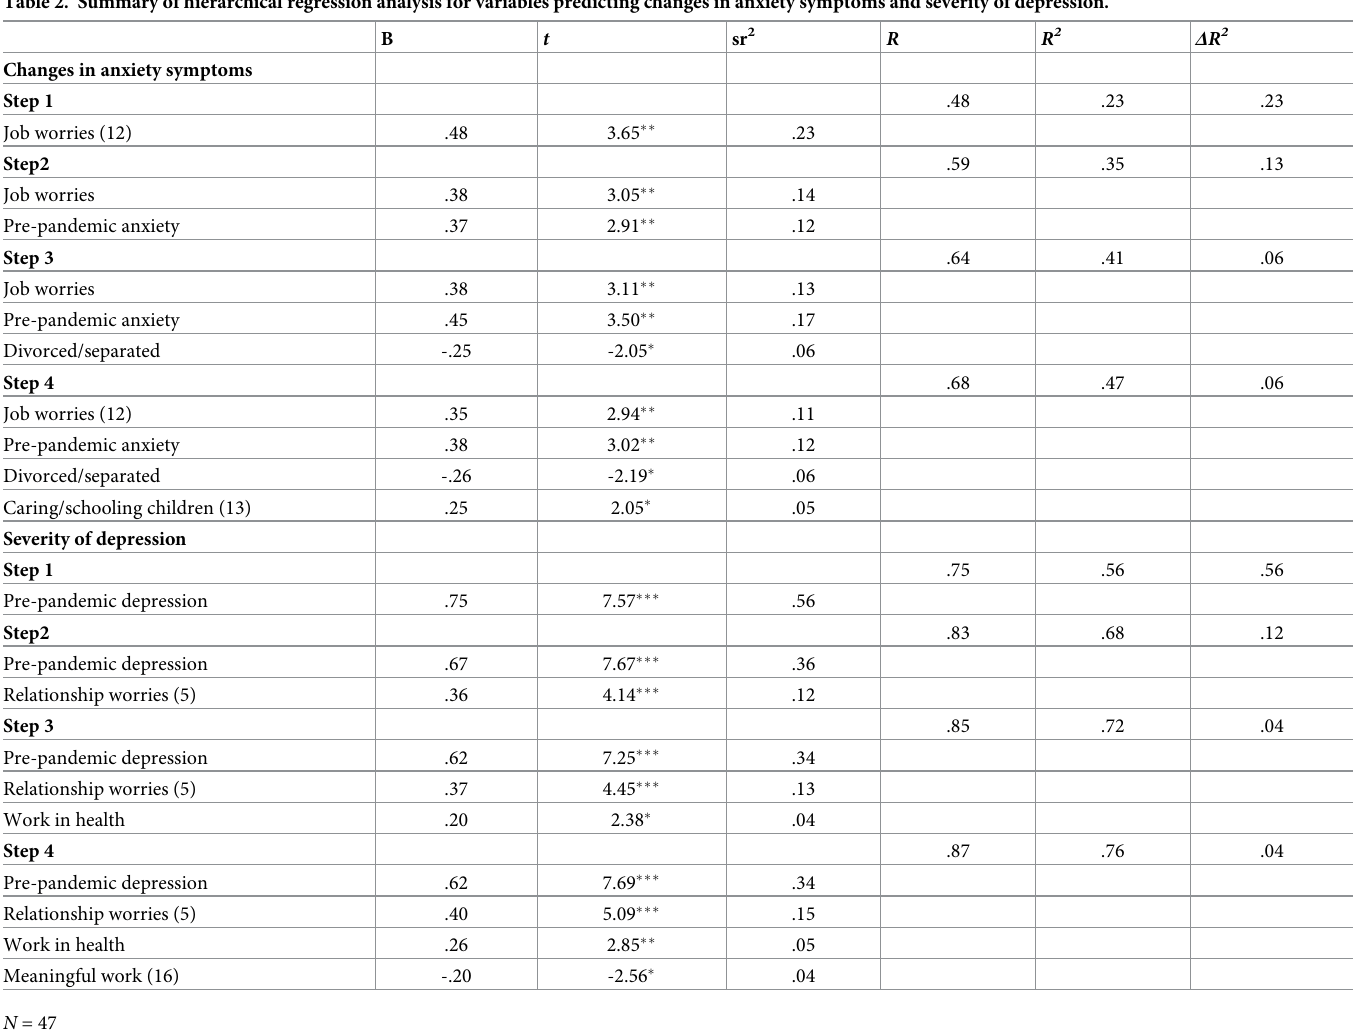
Table 2. Summary of hierarchical regression analysis for variables predicting changes in anxiety symptoms and severity of